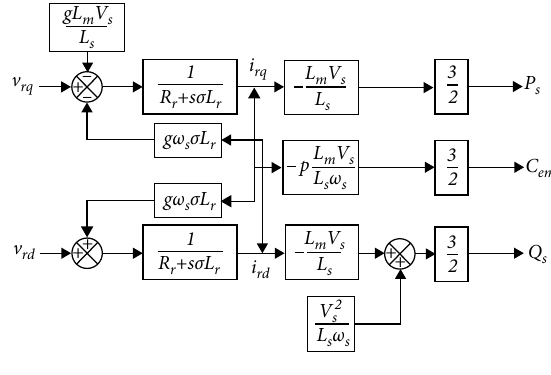
Figure 4: The DFIG’s model